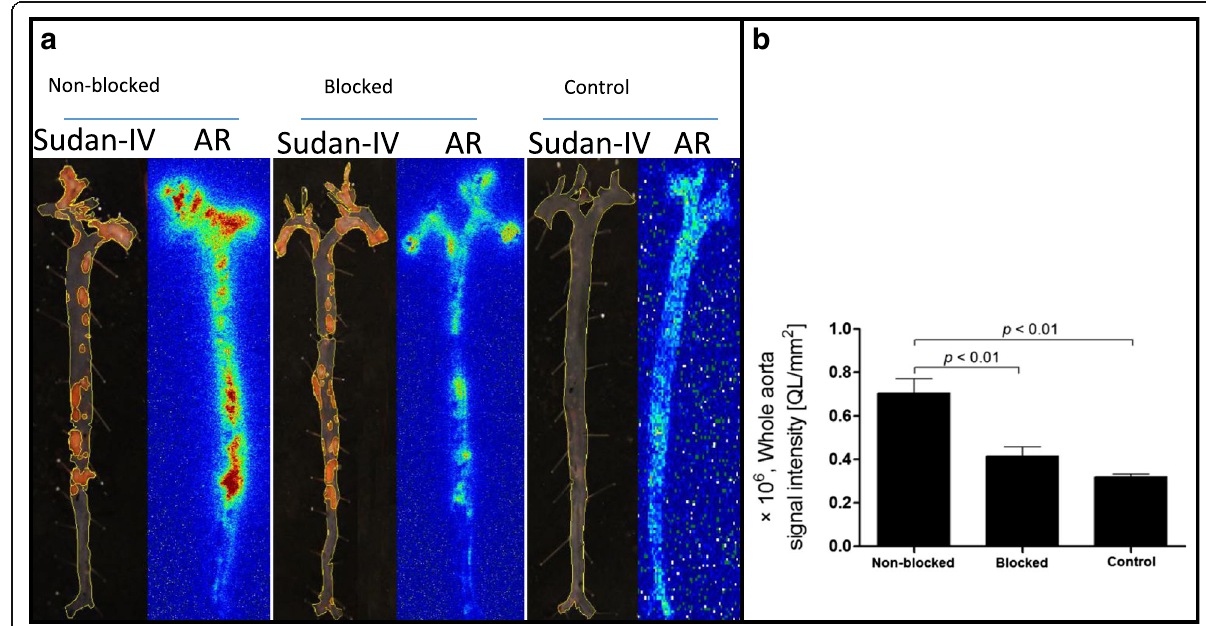
Fig. 4 a Sudan IV staining and corresponding autoradiography (AR) of the aortas extracted from ApoE-KO non-blocked, blocked and control mice.